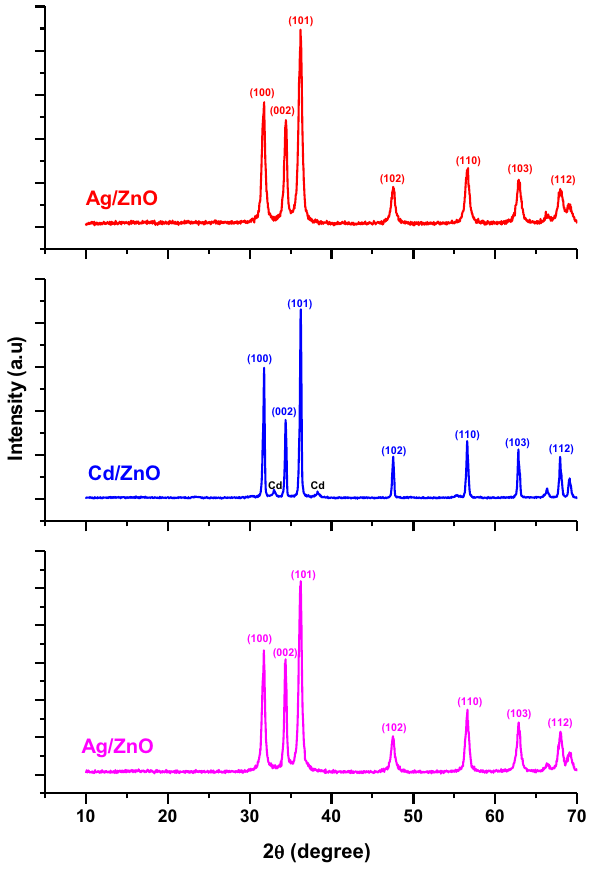
Fig. 2 Powder X-ray diffraction patterns of modified ZnO nanoparti- cles